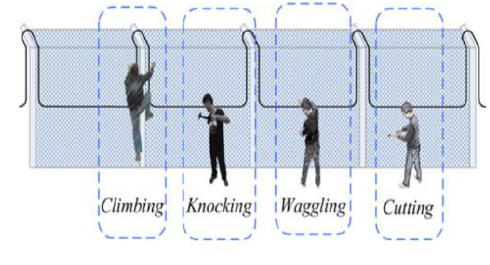
Figure 5. The four typical intrusion events [12]